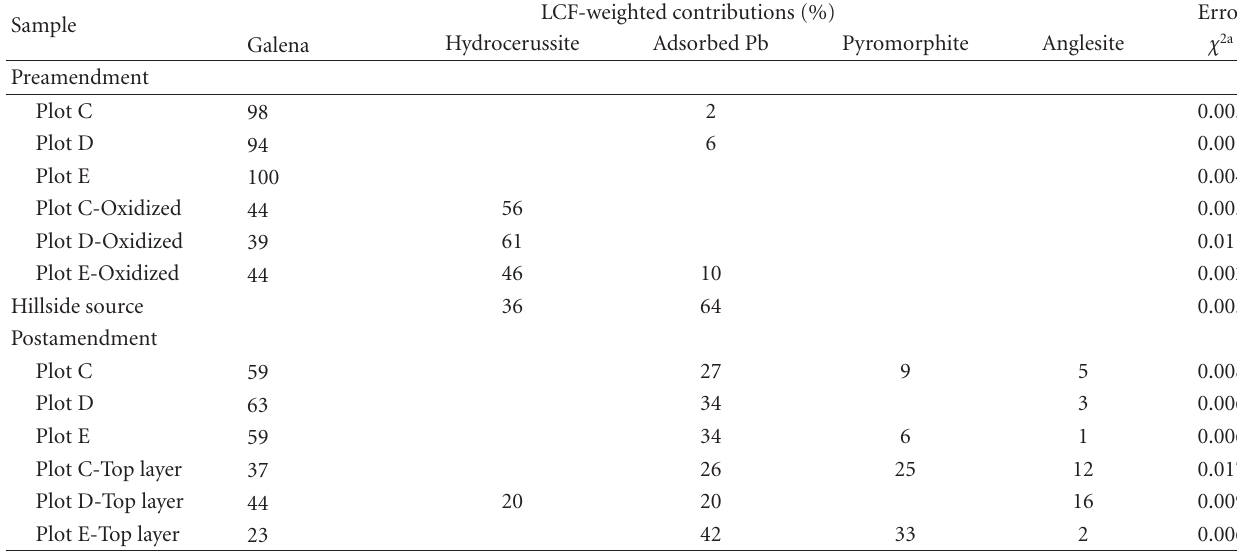
Table 3: Chopawamsic Creek sediment Pb speciation by linear combination fitting (LCF) for preamendment and postamendment experimental plot